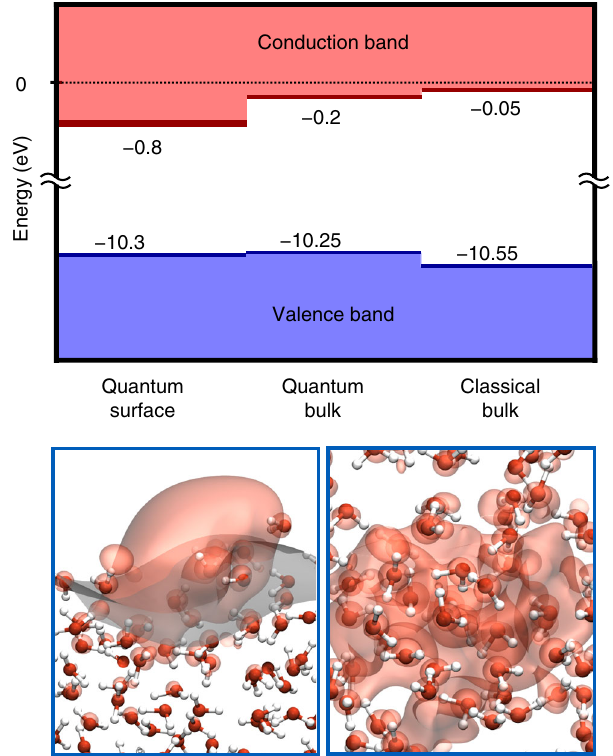
Fig. 1 Computed electronic energy levels of liquid water. Upper panel: Positions of the valence band maxima (VBM, blue) and conduction band minima (CBM, red) of the surface of the water and bulk water computed using the classical and path integral molecular dynamics with the MB-pol potential. All values are in eV. The energy levels were computed using G 0 W 0 starting from hybrid DFT; the range given above (thick bars) corresponds to results obtained with range-separated (RSH) and self- consistent hybrids (see text and Supplementary Tables 7 – 10). Lower panel: Snapshots of the surface of water (left) and of bulk liquid water (right) from path integral MD simulations, together with isoprobability contours (set at 40%) of the lowest unoccupied molecular orbital, as obtained using the RSH functional. The interface between water and vacuum (gray isosurface in the lower left panel) is pictorially represented using a constant density surface de fi ned following the procedure reported in ref.